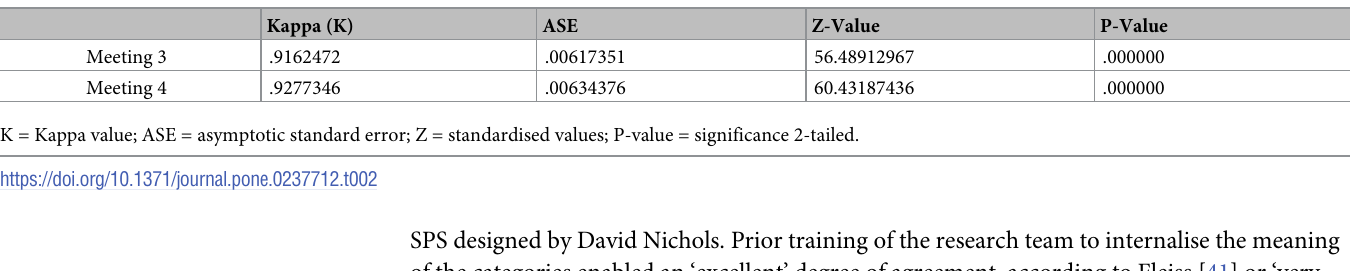
Table 2. Kappa Fleiss calculation.